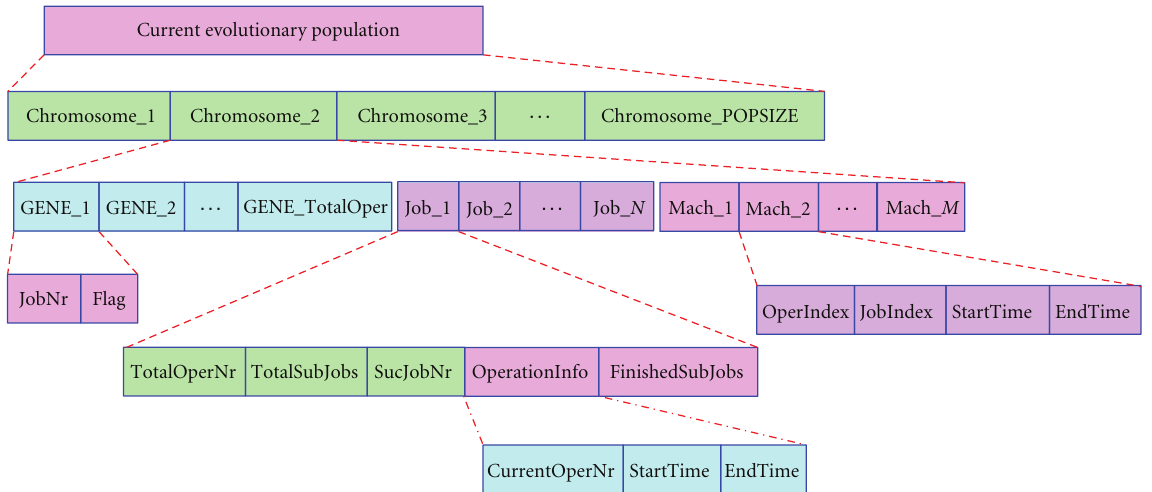
Figure 5: The data structure for decoding